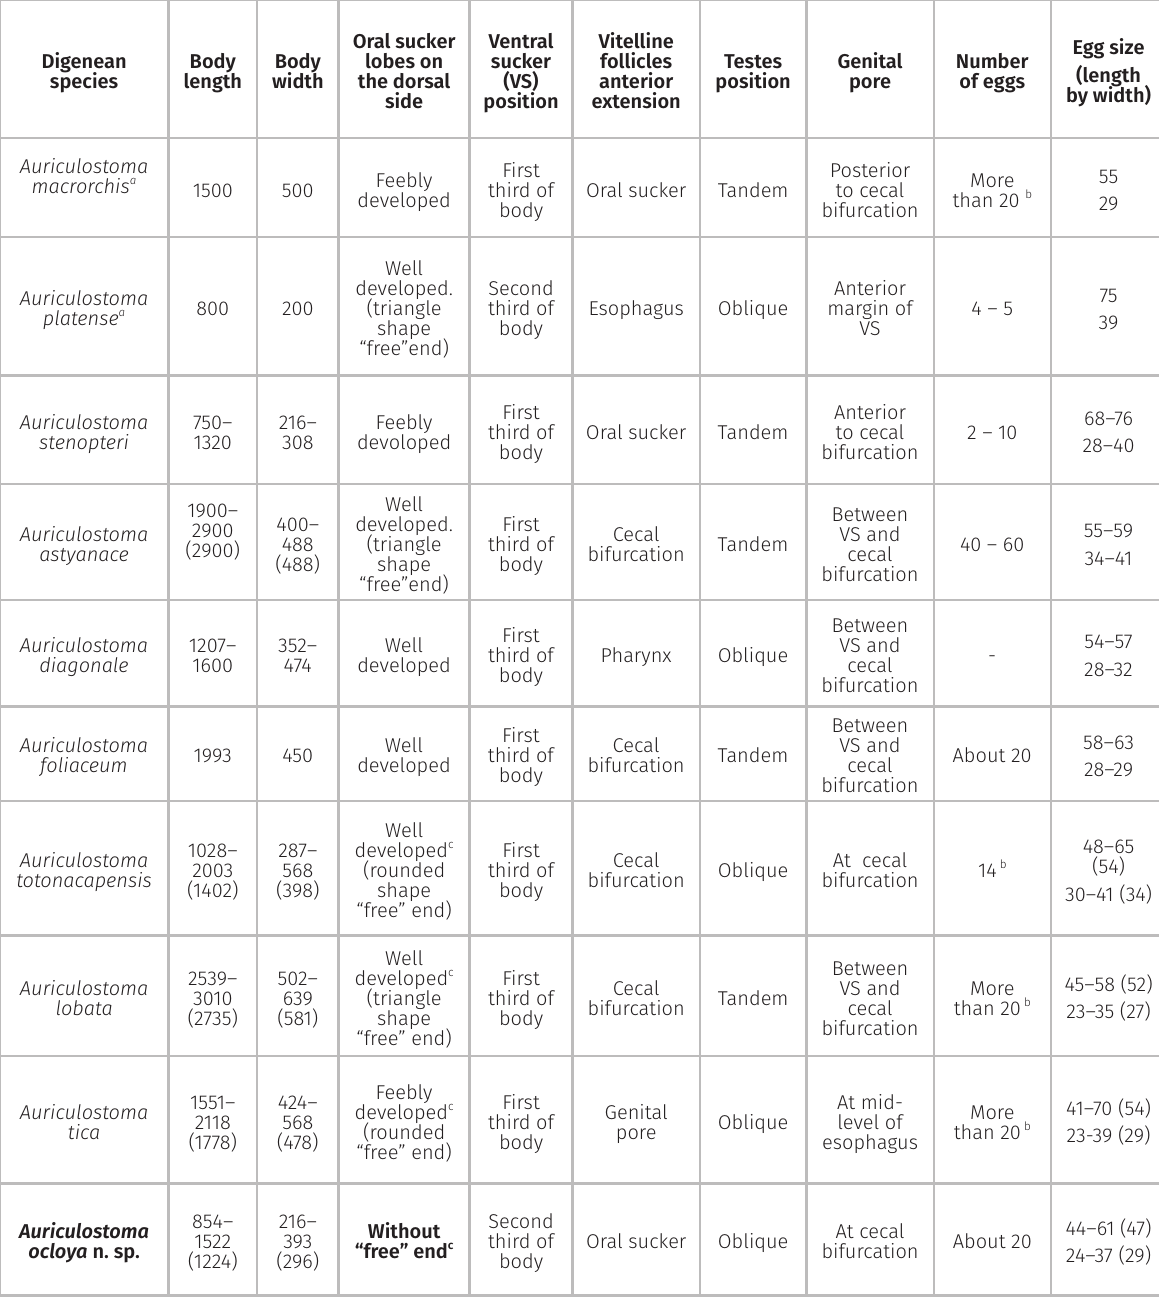
Table II. Comparison of Auriculostoma species (new species is in bold); measurements are presented in micrometers, given range and mean in